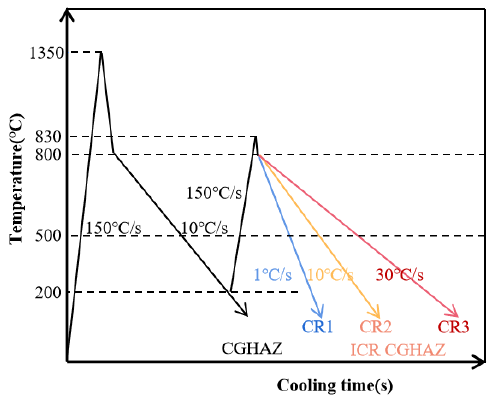
Figure 1. Schematic diagram of welding thermal cycles of ICR CGHAZ.